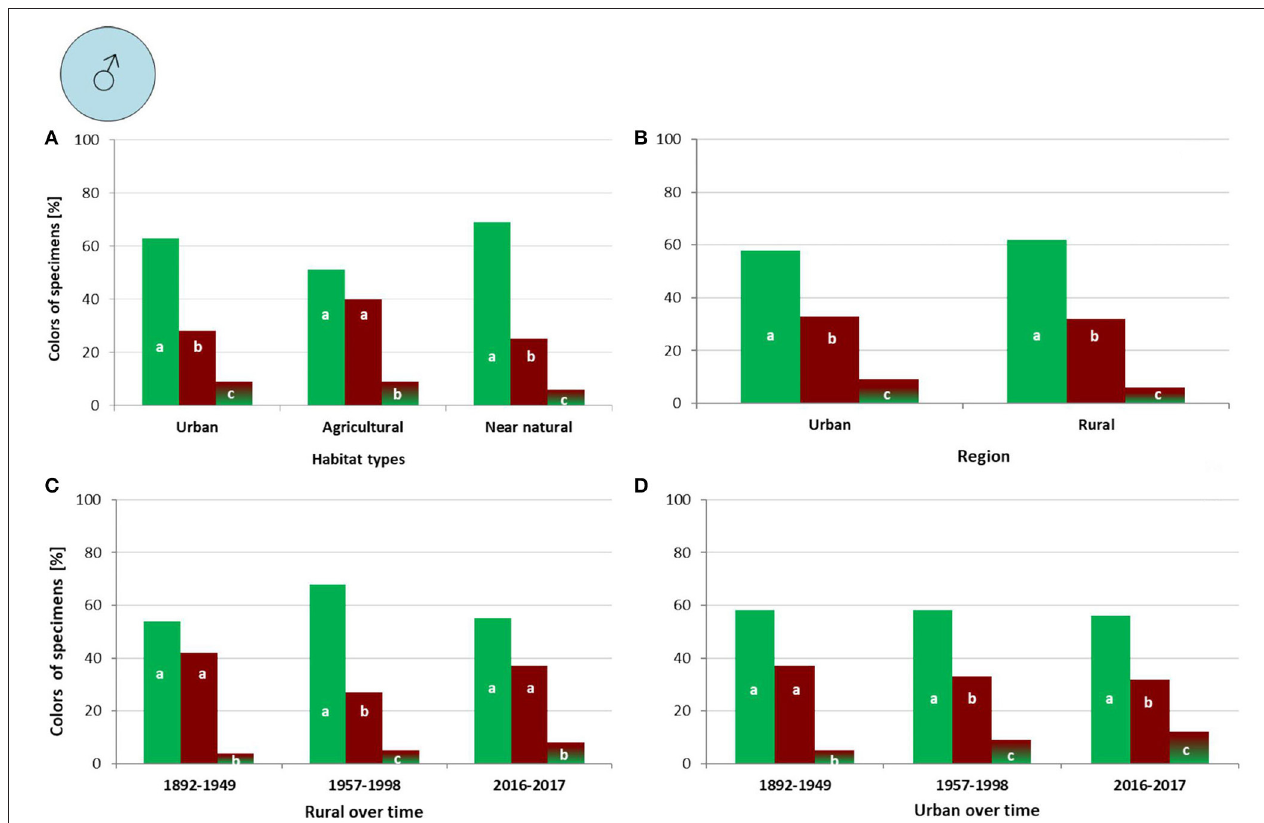
FIGURE 5 | Percentage of male Harpalus affinis color morphs in different habitat types (A) , regions with different urbanization level (B) , and within a particular region during different time periods (C,D) ; different letters indicate significant differences in frequencies of the three color morphs.